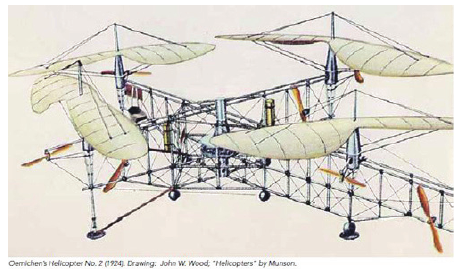
Figure 3 – Helicopter Oemichen No.2 from 1924 Рис . 3 – Вертолет Оихмичена № 2, 1924 г . Слика 3 – Хеликоптер Oemichen број 2 из 1924. године